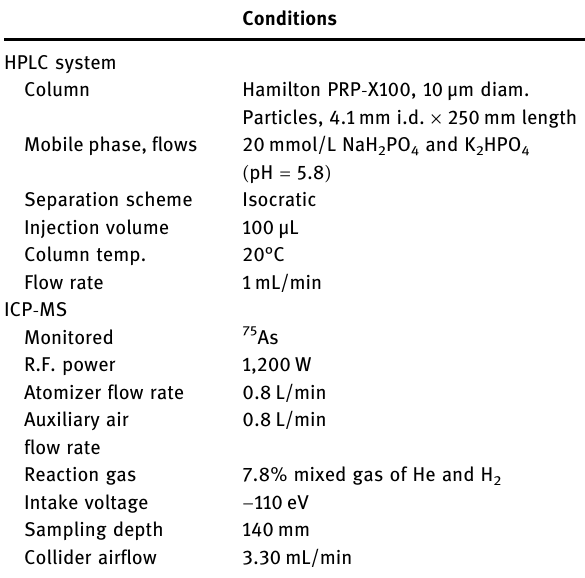
Table 1: Working conditions of HPLC mass